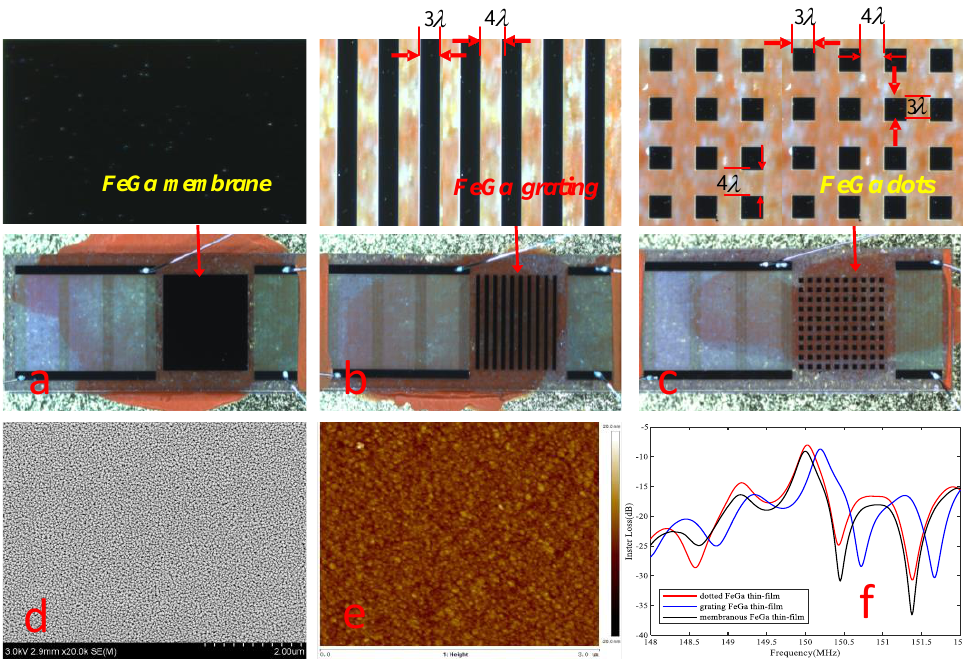
Figure 5. Optica pictures of developed sensing device coated with ( a ) FeGa membranous, ( b ) FeGa grating, ( c ) FeGa dots, ( d ) SEM view, and ( e ) AFM picture of the FeGa thin film, and ( f ) measured frequency characteristic of the fabricated sensing devices.